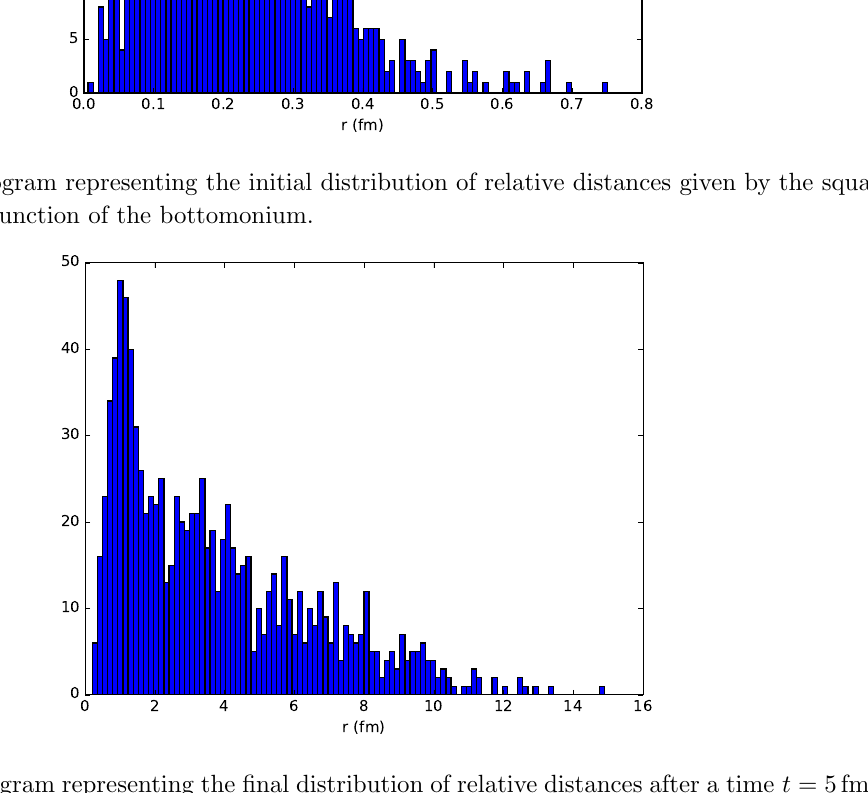
Figure 9 . Histogram representing the (cid:12)nal distribution of relative distances after a time t = 5 fm = c assuming the initial distribution of (cid:12)gure 8. Note the change in horizontal scale with respect to (cid:12)gure